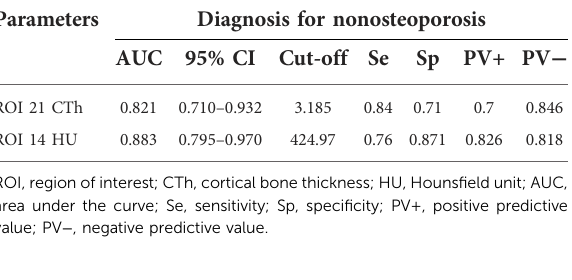
TABLE 3 Diagnostic ef fi ciency of ROI 21 CTh and ROI 14 HU value for osteoporosis. Parameters